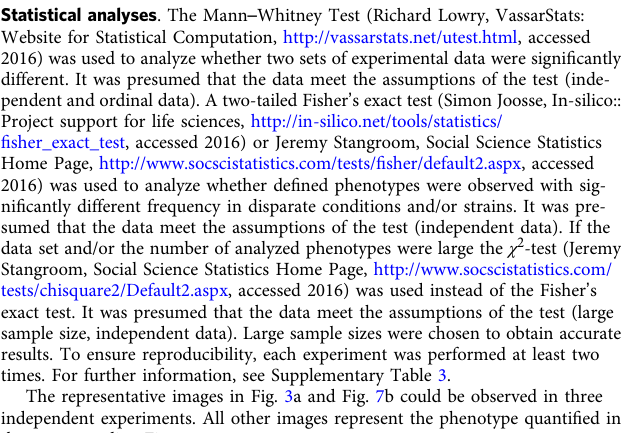
Figure 5a – d: Cells grown logarithmically in SC medium containing 2% glucose and no methionine were shifted to YP medium containing 2% glucose and 2mM methionine to arrest cells in metaphase, and analyzed 3.5h later in NFM medium containing 2% glucose and 2mM methionine. For Stu1 depletion, IAA was added to 1mM 2 h after the shift to YP medium. Cells were analyzed in NFM medium containing 2% glucose, 2 mM methionine, and 1mM IAA. Supplementary fi gure 3: Cells grown logarithmically in YP medium with 2% raf fi nose and 1% galactose were arrested in G1 for 2 h, then released into YP medium with 2% glucose (for Cdc20 depletion) and 15 µ g ml – 1 nocodazole and analyzed 3h after the G1 release. To deplete Spc105, Bub3, and background